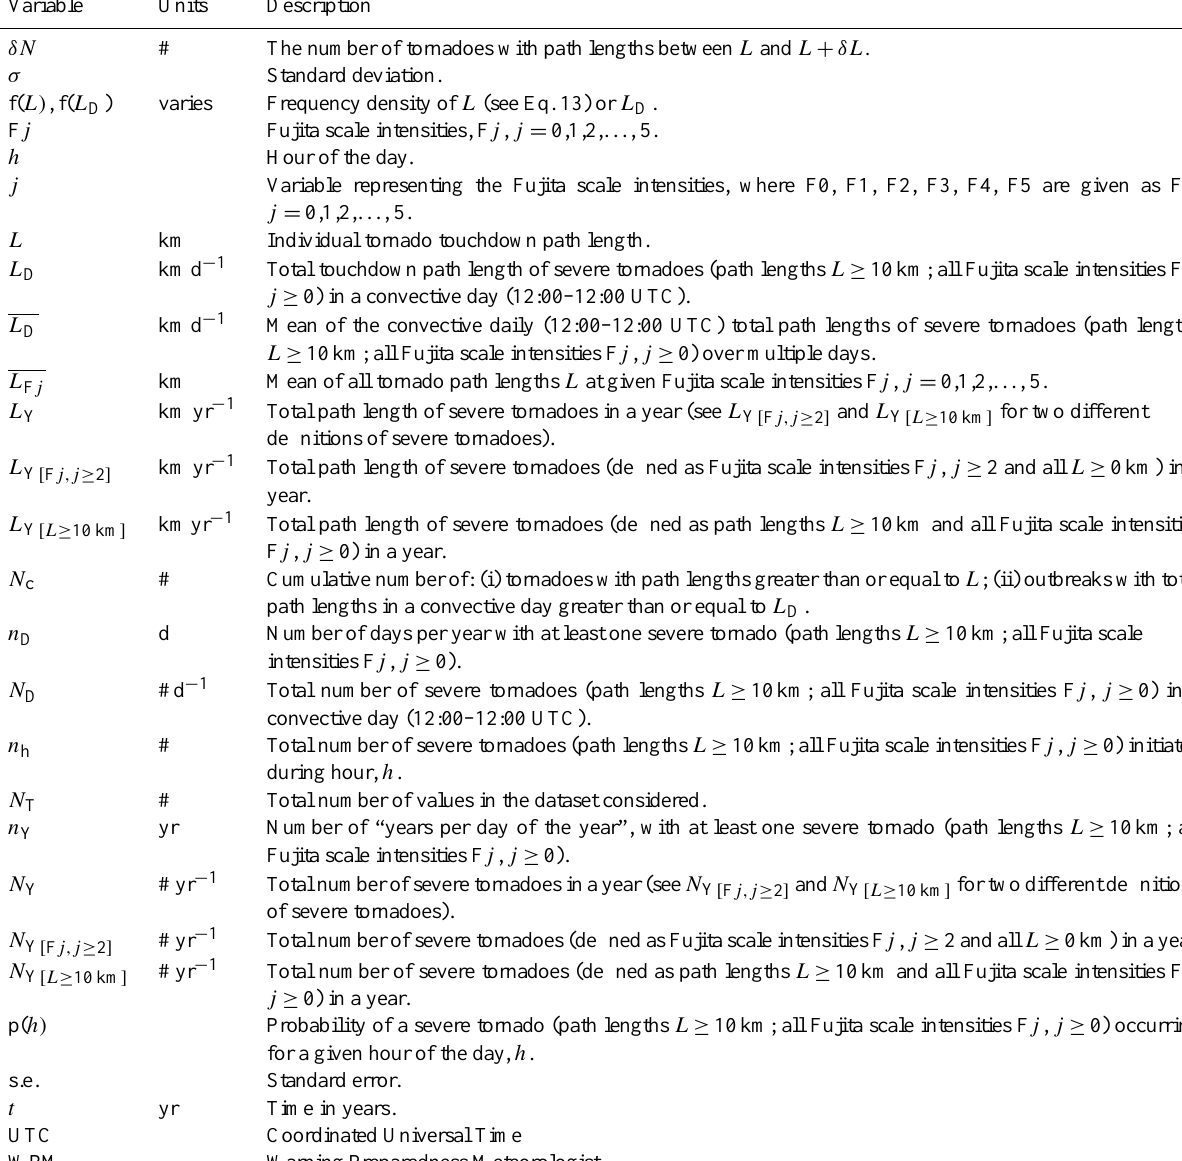
Table 3. List of symbols and